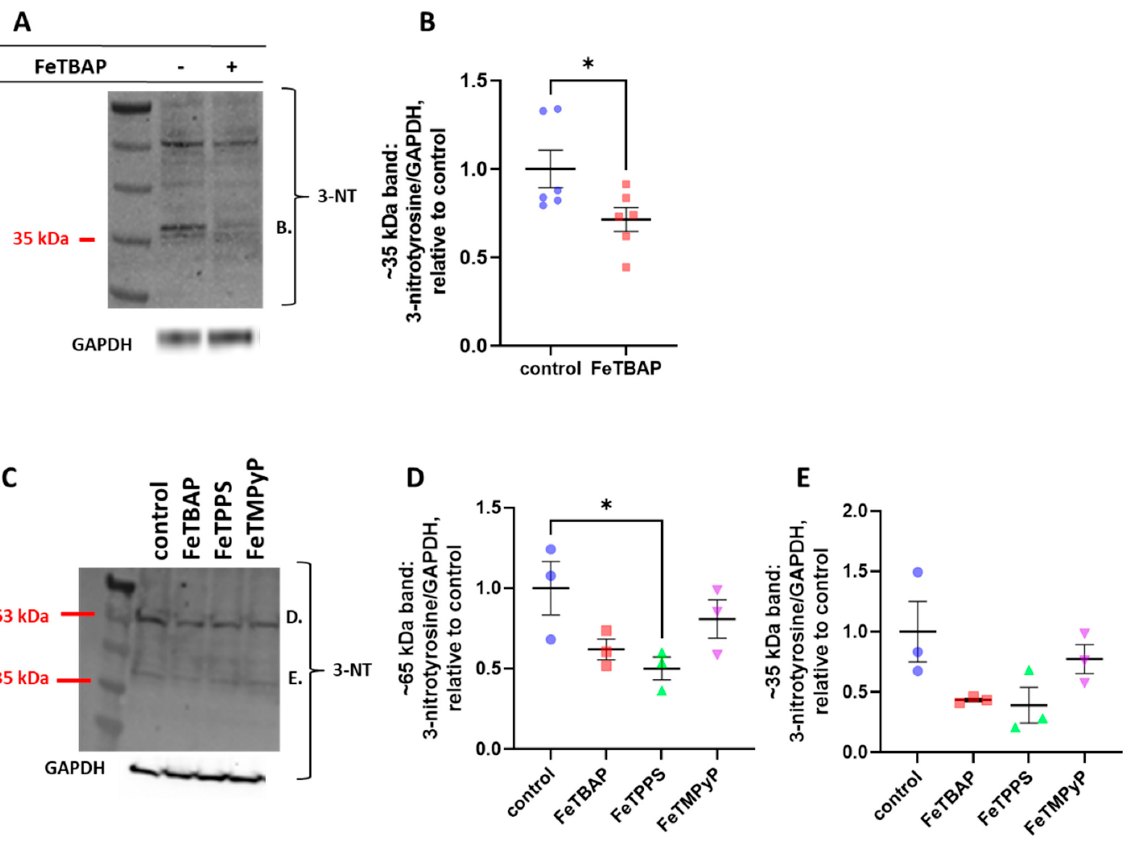
Figure 3. FeTBAP and FeTPPS decrease nitrotyrosine levels in C2C12 myotubes. C2C12 myotubes were incubated in the absence or presence of 150 µM FeTBAP, FeTPPS, or FeTMPyP for 18 h. ( A , B ) Western blot and quantitation for 3-nitrotyrosine and glyceraldehyde phosphate dehydrogenase (GAPDH) after incubation with FeTBAP. ( C – E ) Western blot and quantitation for 3-nitrotyrosine C – E ) Western blot and quantitation for 3-nitrotyrosine and and GAPDH after incubation with FeTBAP, FeTPPS, or FeTMPyP. * p < 0.05 vs. control. (GAPDH) after incubation with FeTBAP. ( GAPDH after incubation with FeTBAP, FeTPPS, or FeTMPyP. * p < 0.05 vs.